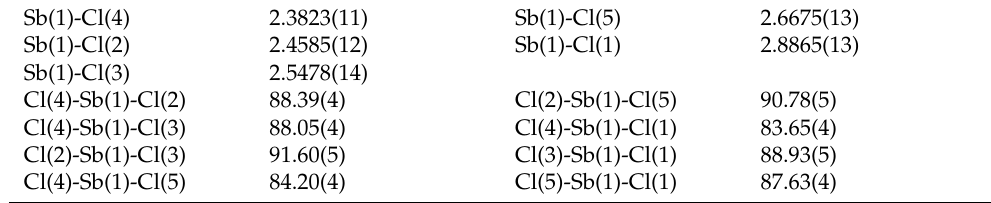
Symmetry transformations used to generate equivalent atoms: n/a . Table 2. Hydrogen bonds for [H 2 BPZ][SbCl 5 ] · H 2 O at 293